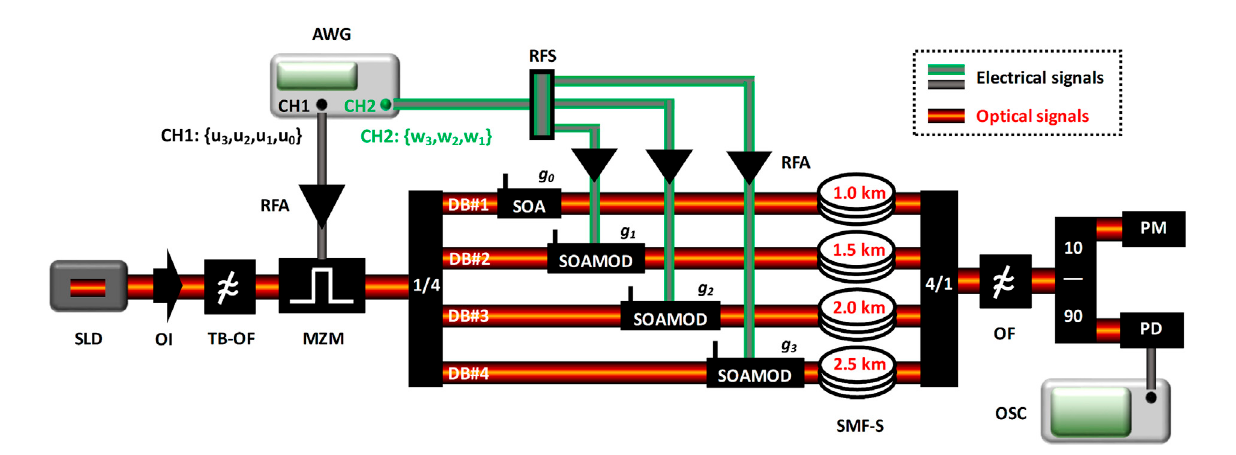
FIGURE 3 Optoelectronic dendritic unit (ODU) with four dendritic branches (DB), in a coincidence detection architecture. SLD, Superluminescent diode, OI, Opticalisolator,TB-OF,Tunable-bandwidthoptical fi lter,MZM,Mach-Zehndermodulator,1/4,One-to-fouropticalsplitter,SOA,Semiconductoroptical ampli fi er, SOAMOD, Semiconductor optical ampli fi er operating as modulator, SMF-S, Single-mode fi ber spool, 4/1, Four-to-one optical coupler, OF, Tunable optical fi lter, 10/90, Optical splitter, PM, Powermeter, PD, Photodetector, OSC, Real-time oscilloscope, AWG, Arbitrary waveform generator, RFA, RF ampli fi er, RFS, RF